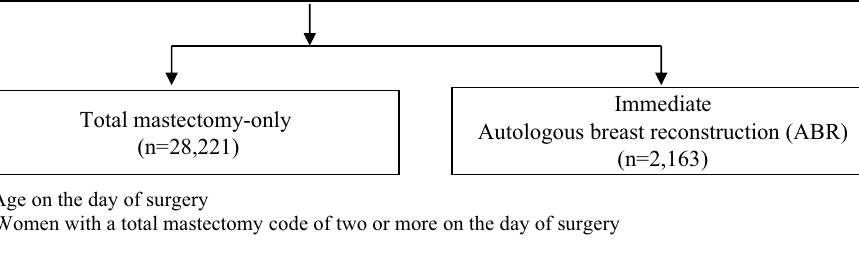
Figure 1. Flowchart of the selection of the study